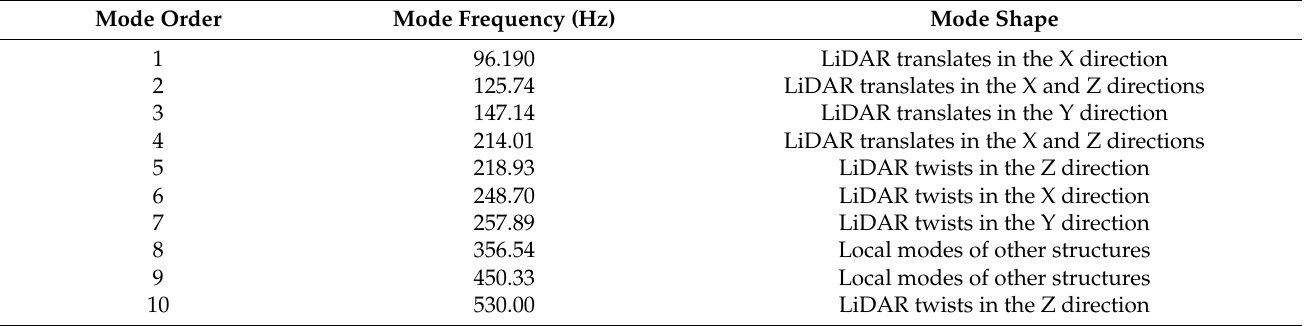
Table 3. Modal Frequency and Formation of UAV Radar Installation Platform System (Top 10 Stages).